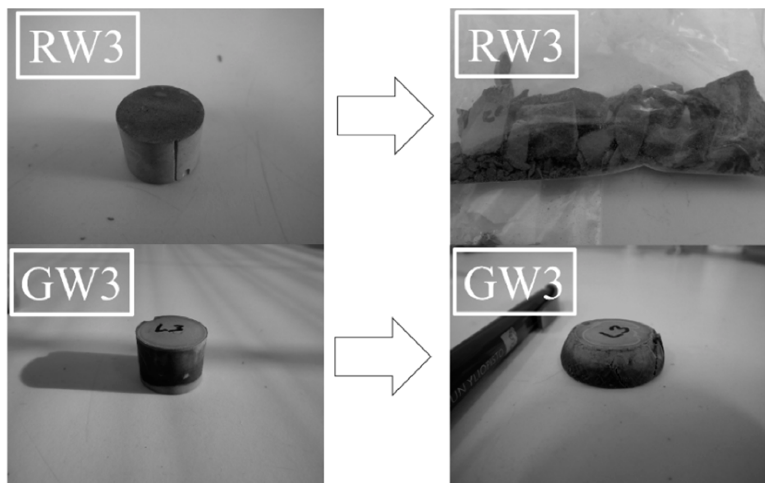
Figure 4. The deformation type of the alkali activated rock wool (RW) and glass wool (GW) samples.